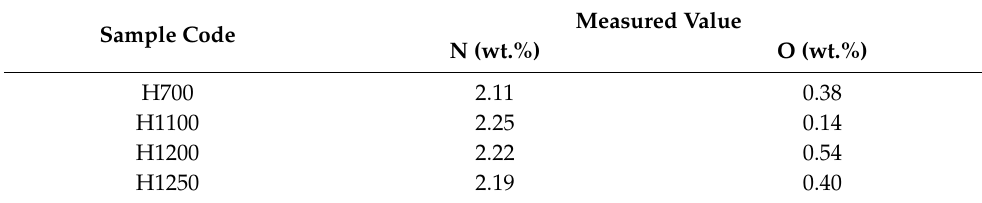
Table 4. The overall nitrogen and oxygen contents of porous samples reduced by H 2 .